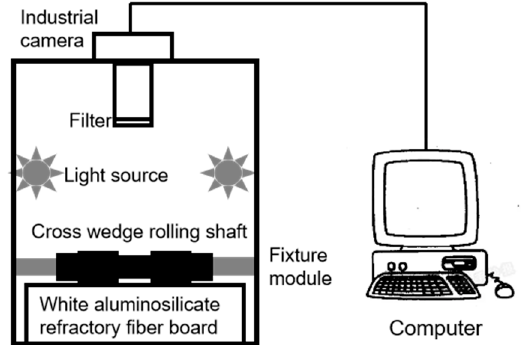
Figure 2. Schematic diagram of the surface hollow defect detection